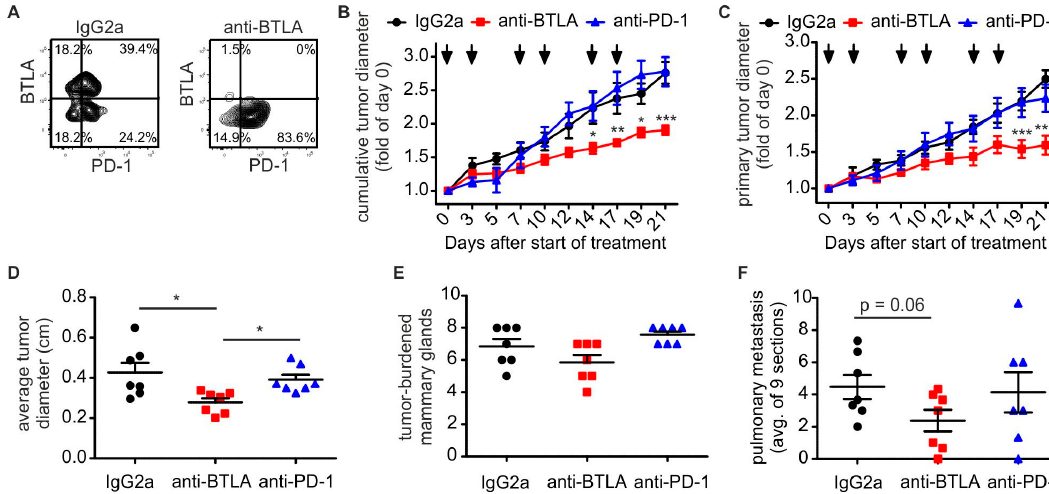
Figure 2. Anti-BTLA antibodies reduce PyMT tumor growth. PyMT tumors were treated with 5 mg/kg of each anti-BTLA, anti-PD-1 or isotype control (IgG2A) antibodies ( n = 7 each) twice weekly for three weeks once the first tumor reached a size of 0.5 cm in diameter. ( A ) Representative FACS plots show expression of BTLA on T cells after treatment with anti-BTLA or isotype control antibody. ( B , C ) Cumulative tumor diameters ( B ); and the diameter of the primary tumor ( C ) over time are shown. ( D – F ) The endpoint, the average tumor diameter per mammary gland ( D ); the number of tumor-burdened mammary glands ( E ); and the occurrence of pulmonary metastasis ( F ) are displayed. p -values were calculated using two-way ANOVA ( B , C ) or one-way ANOVA ( D – F ) with Bonferroni’s correction, * p < 0.05, ** p < 0.01, *** p < 0.001.